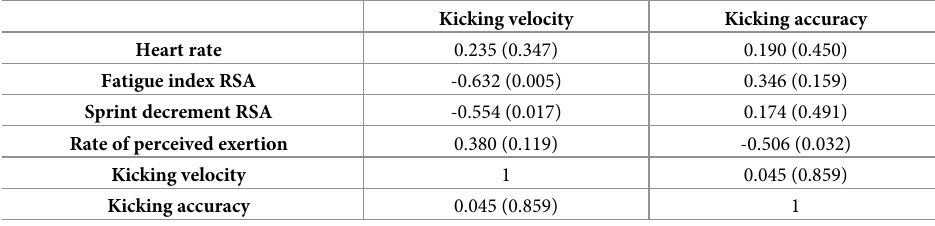
Table 3. Correlations between fatigue measures and kicking velocity and accuracy � .